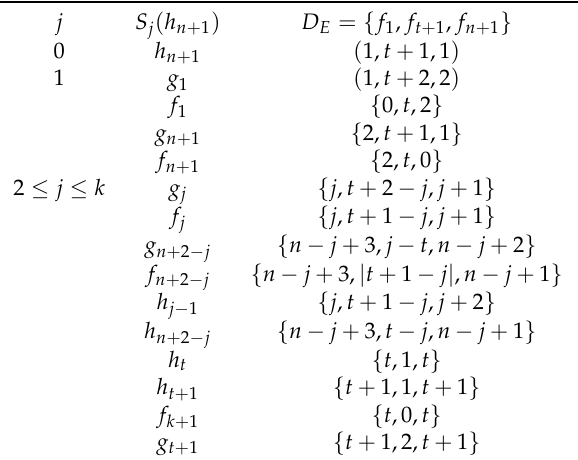
Table 3. Vectors of edge version of representations of N e